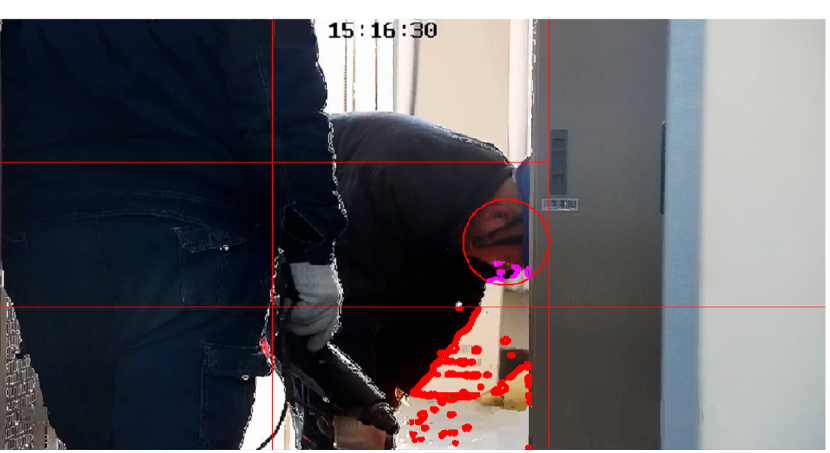
Figure 11. Safety glasses detection on the construction site.